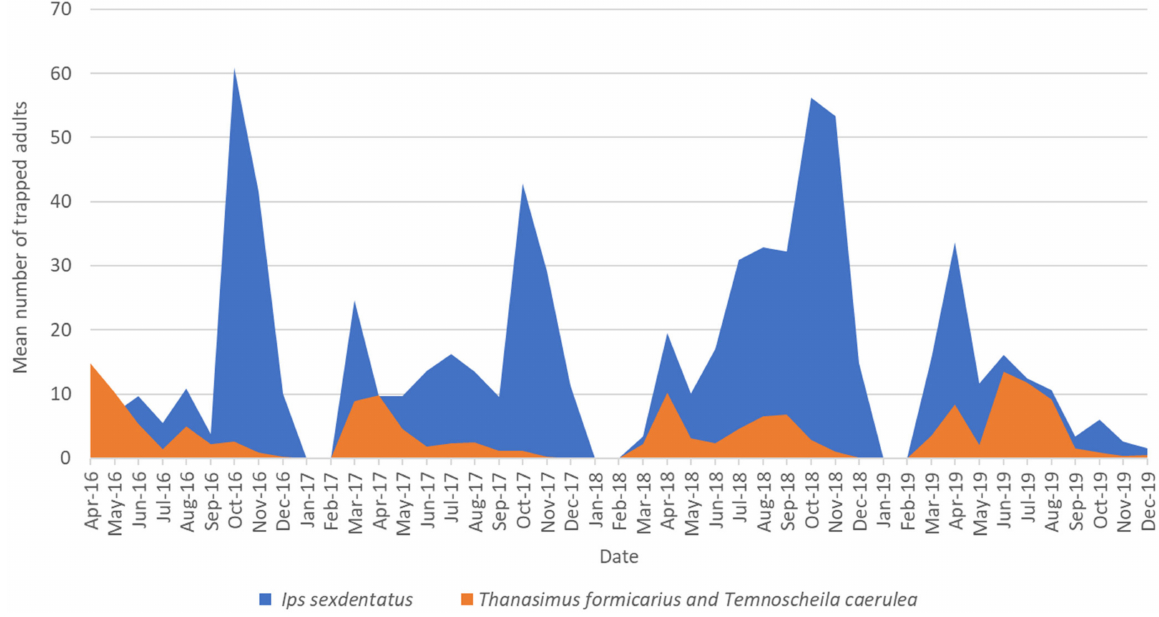
Figure 3. Mean number of trapped adults of Ips sexdentatus and its main predators ( Thanasimus formicarius and Temnoscheila caerulea ) in the study site (Municipality of Grosseto, Tuscany, Italy) using standard slot traps, from 2016 to